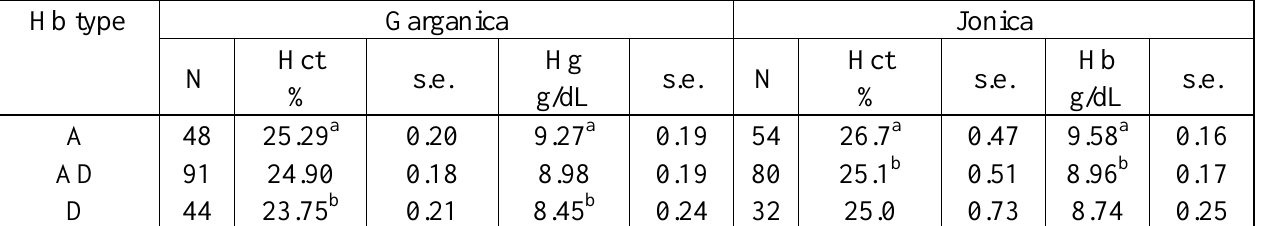
Table 10. Least square mean values and standard error (s.e.) of hemoglobin (Hb) and hematocrit value (Hct) for electrophoretic phenotype in Garganica goats and Jonica goats. Means with different superscripts differ significantly (P < 0.05).